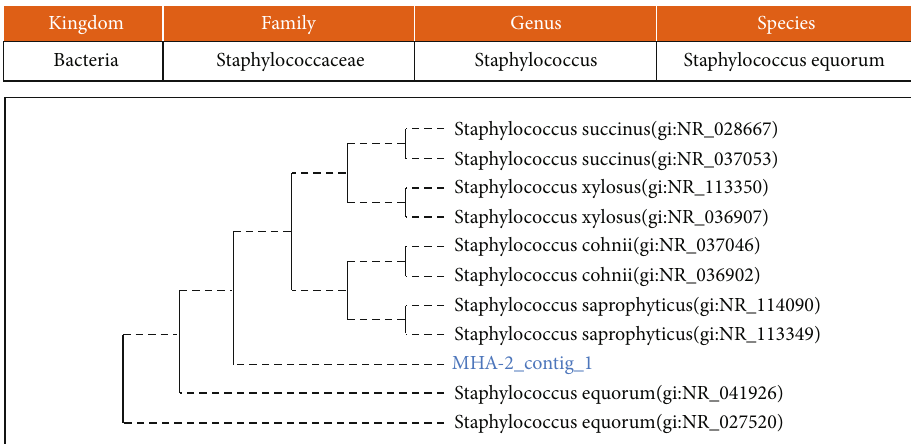
Figure 4: The phylogenetic study of isolate MHA-2/MHA KP.